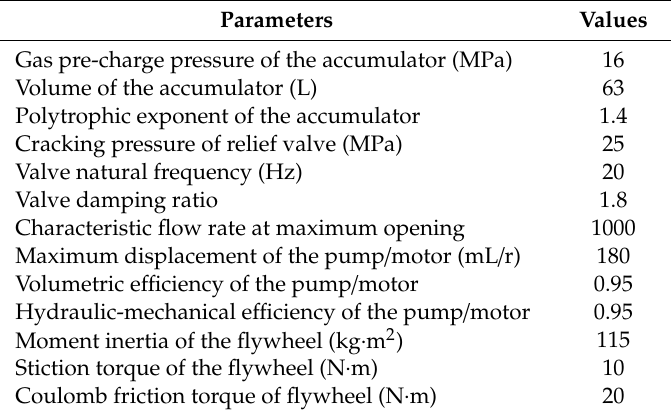
Table 1. Parameters of the components of the regenerative braking